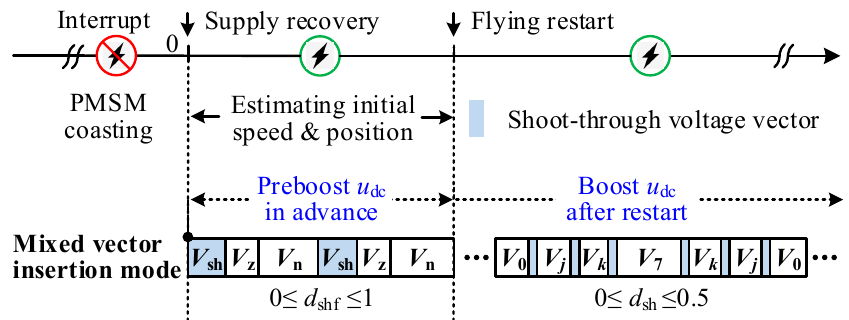
Figure 4. Equivalent circuit of the PMSM system driven by qZSI.